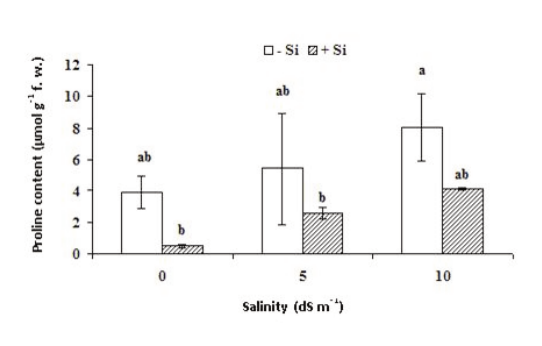
Fig. 7 - Comparison of different concentrations of salts (A: 5 dS m -1 , B: 10 dS m -1 , C: 15 and D: 20 dS m -1 with Si (+Si) and without Si (-Si) in P. pratensis 45 days after beginning the